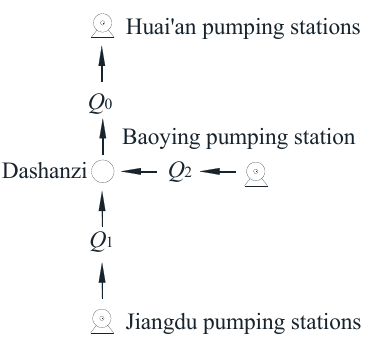
Figure 5. Water distribution diagram at Dashanzi.